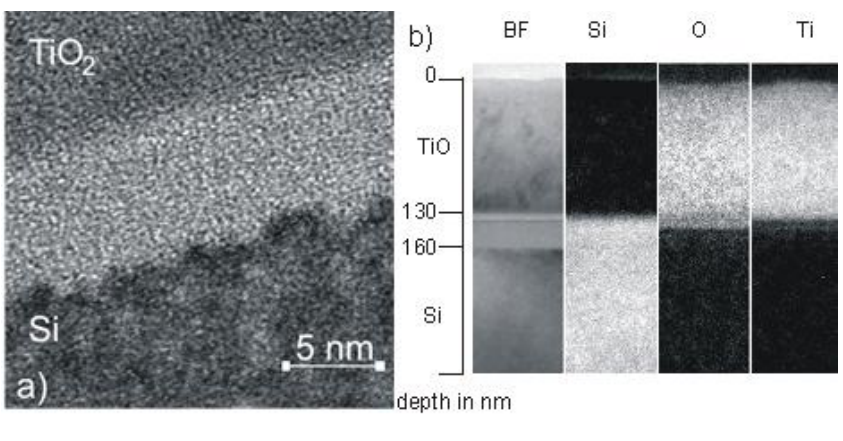
Figure 8 . TEM image of the interface of a TiO pulses on Si(100) and (b) 10 kV bias voltage